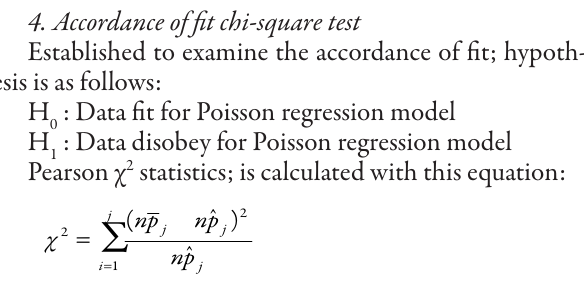
: Data disobey for Poisson regression H 1